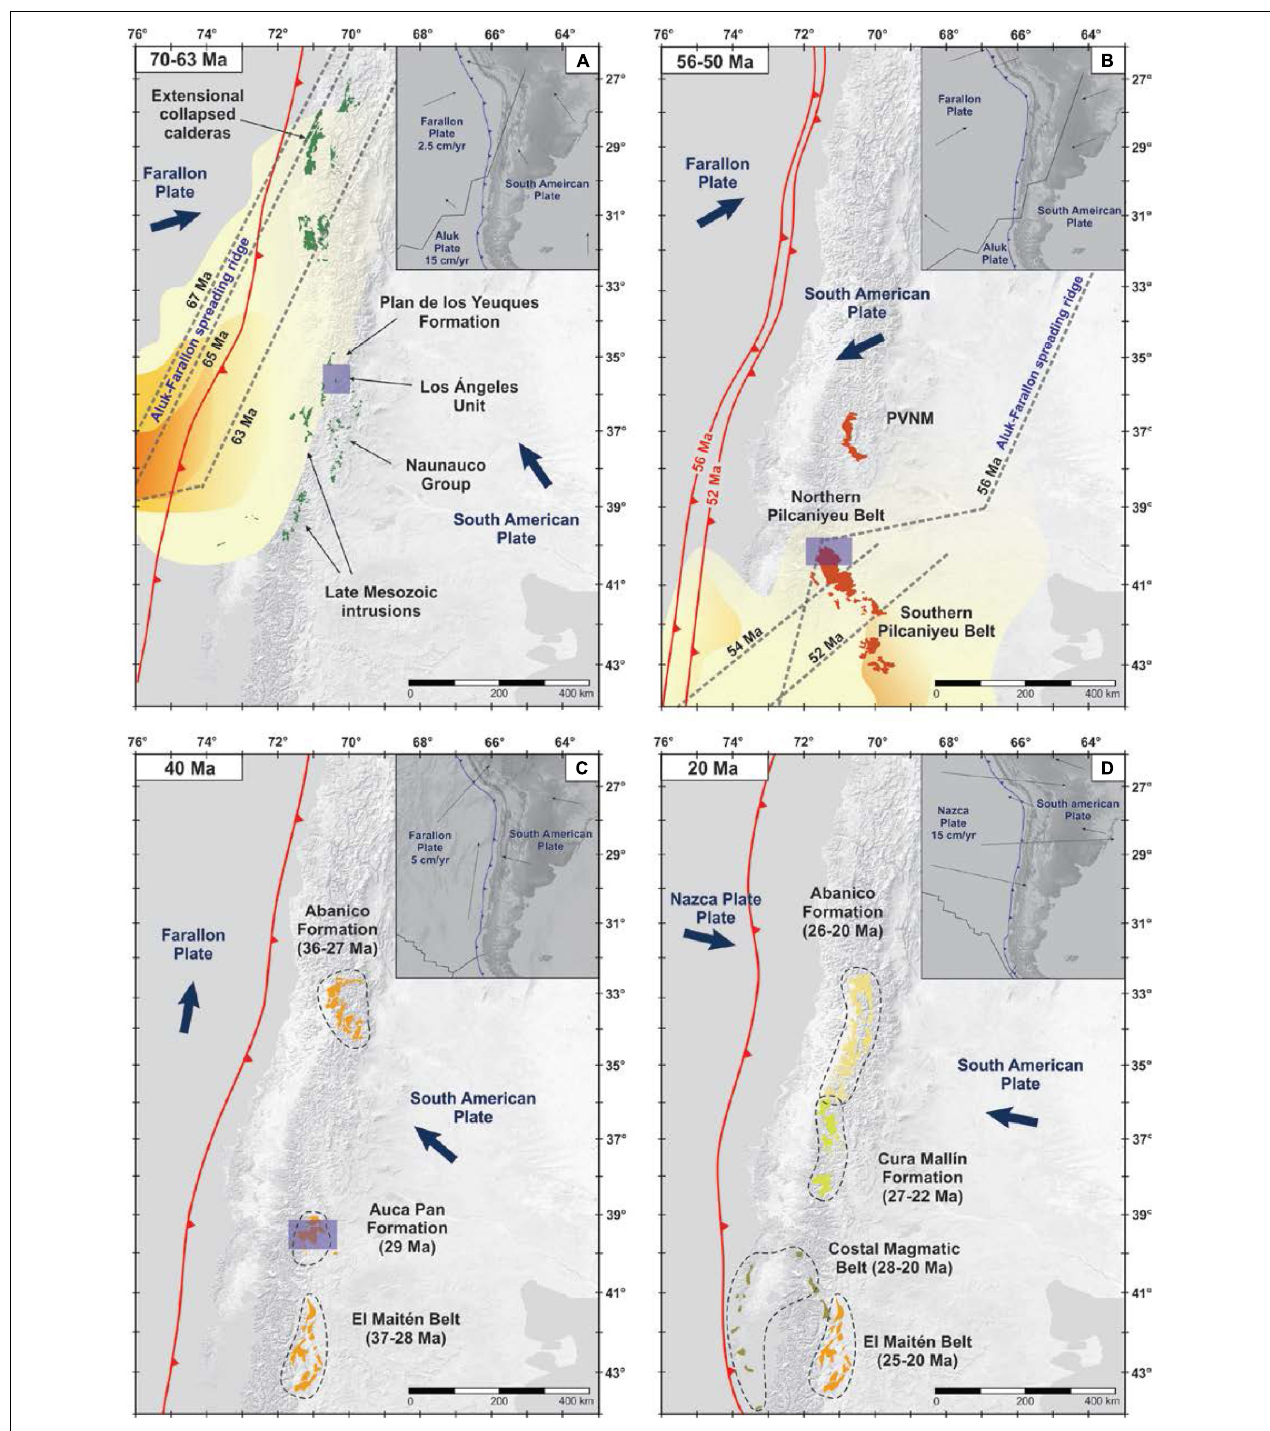
FIGURE 13 | (A,B) Schematic maps that represent the southward movement of the Farallon–Aluk spreading ridge for the Late Cretaceous–early Paleocene (70–63 Ma) and the early Eocene (56–50 Ma) period. The orange to yellow field represents the location of the Farallon–Aluk spreading ridge according to the tomography results. The blue shaded squares show the studied areas in each figure. The green outcrops represented in (A) corresponds to the Late Cretaceous–early Paleocene magmatism (80–59 Ma) while the orange outcrops in (B) are the early Paleocene–late Eocene magmatism (59–37 Ma). (C) Late Eocene–early Oligocene magmatic units emplaced along the Southern Central Andes (35–42 ◦ S). Blue arrows represent the convergence direction for both the Farallon and South American plates. (D) Early Oligocene–early Miocene magmatic units emplaced along the Southern Central Andes after Farallon plate break-up. In this case, blue arrows represent the convergence direction for both Nazca and South American